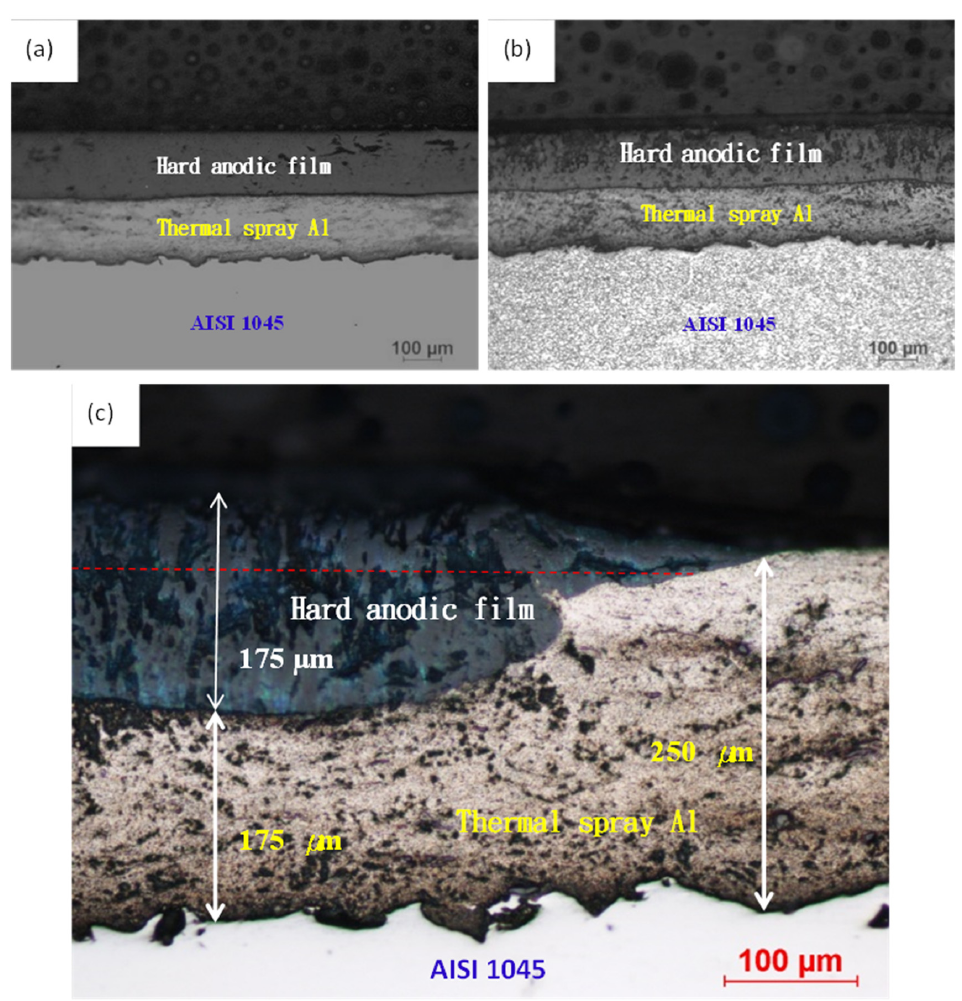
Figure 10. Optical micro-images of thermally sprayed Al on AISI 1045 after hard anodization; ( a ) before etching, ( b ) after etching, and ( c ) partial enlarged view.